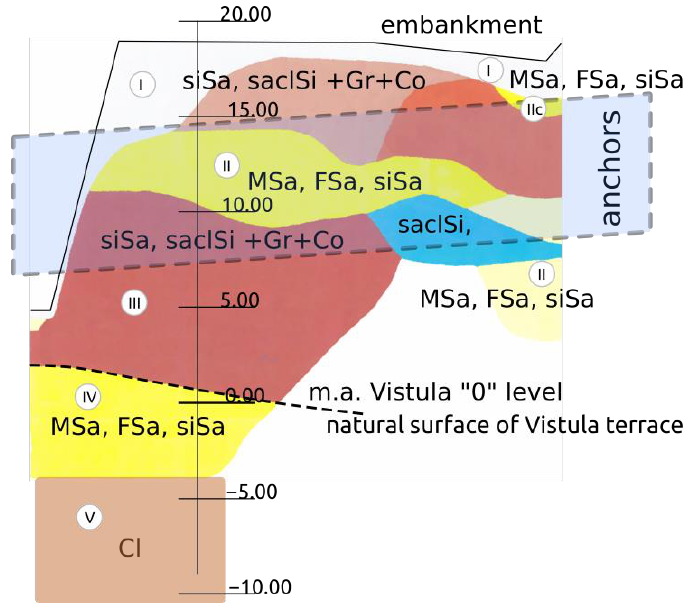
Figure 6. Cross-section along the road support (with courtesy of Geoteko data [40]).